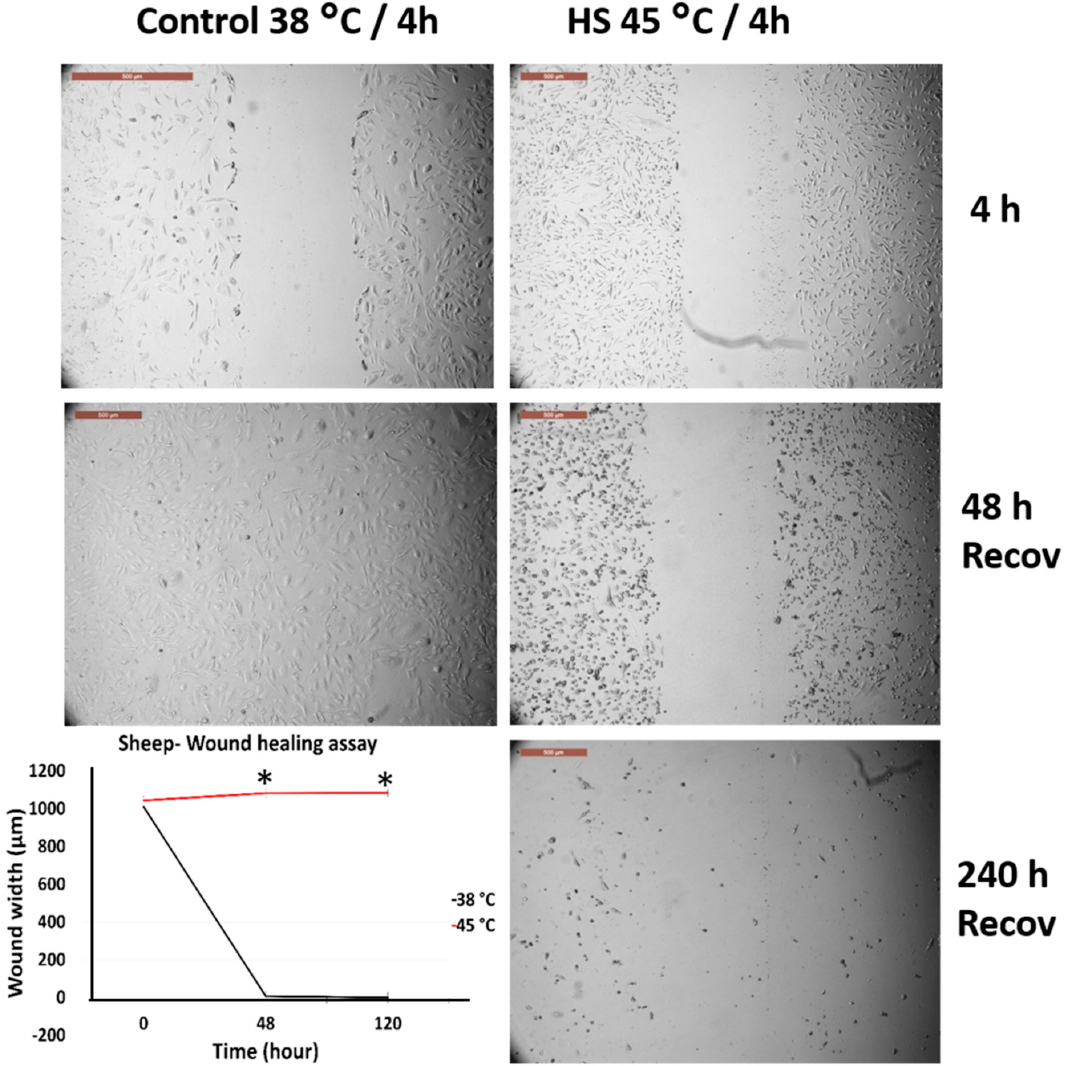
Figure 5. Wound healing (cell scratch) assay for sheep primary cultured fibroblasts that recovered after exposure to 45 °C for 4 h and reached confluency as compared with the control cells (38 °C for 4 h). The wounds were created after cell recovery at confluency. Cells were incubated under the required conditions, recovered at 38 °C, and monitored daily for wound closure. Scale bar = 500 µm. Data are presented as means ± SEM, values of the same timings were analyzed using Student’s t -test, and asterisks (*) indicate significant differences at p < 0.05.